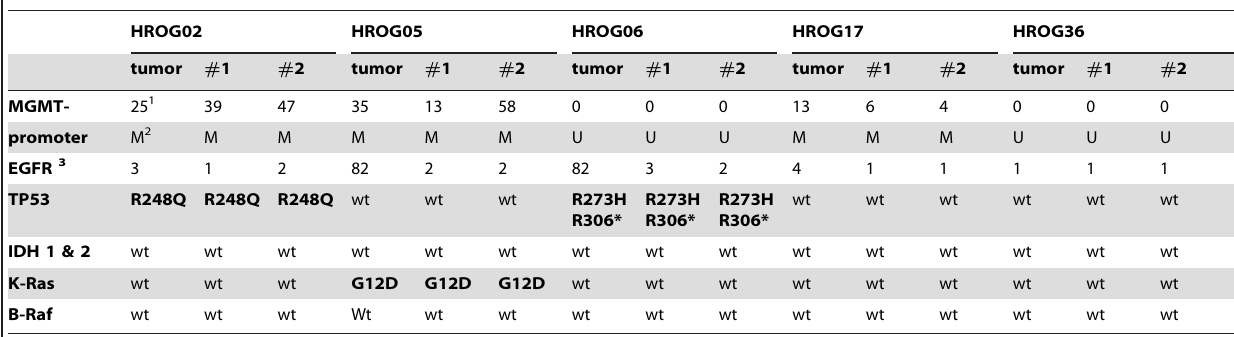
Table 4. Molecular